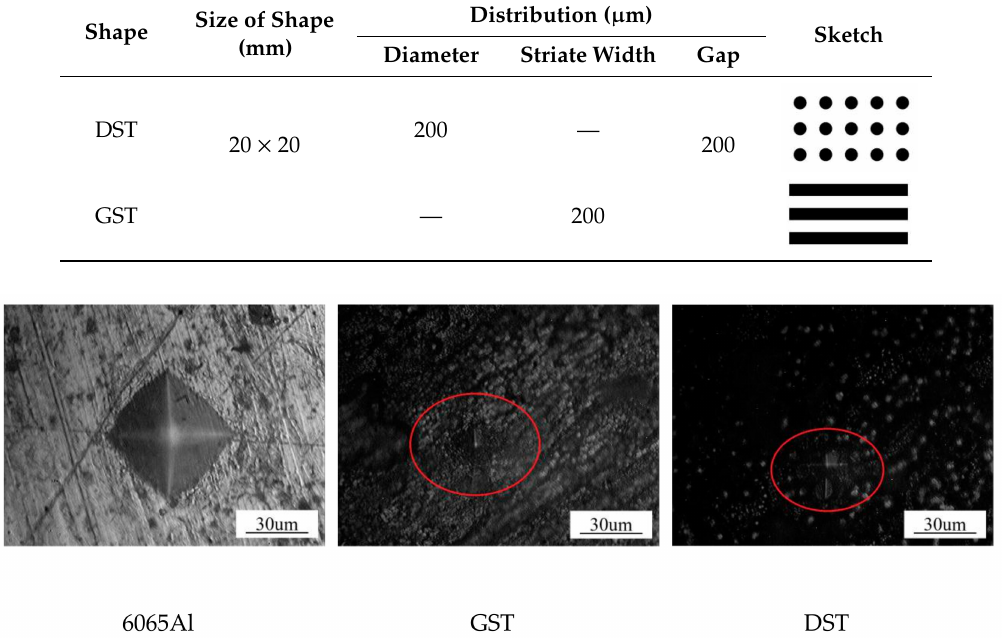
Figure 2. Micro-hardness Indentation on the surface of di ff erent